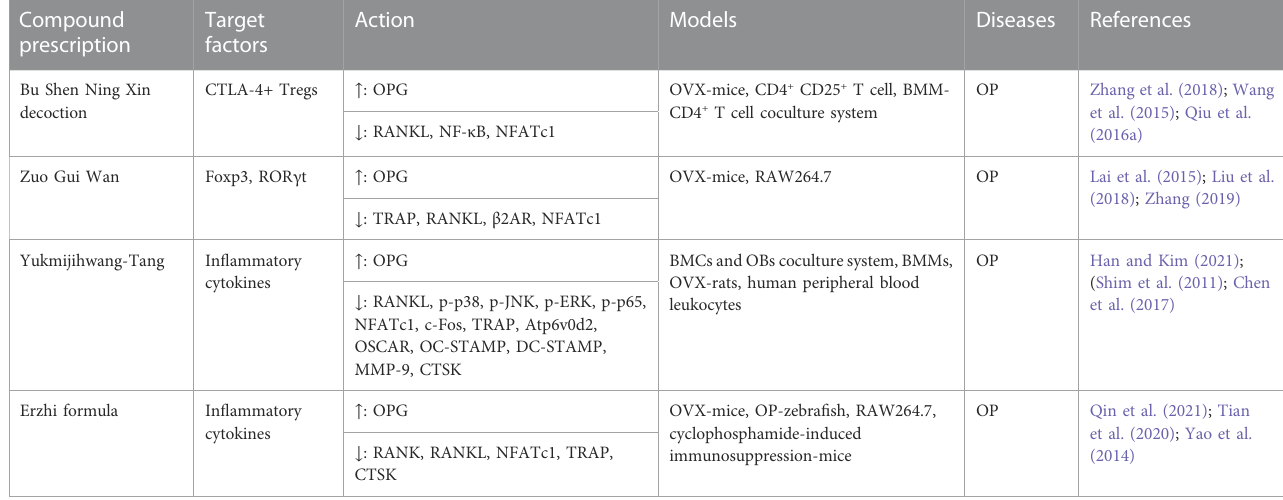
TABLE 3 Immunoregulation mechanisms by which nourishing kidney-yin of TCM compound prescription inhibit osteoclastogenesis. Compound prescription